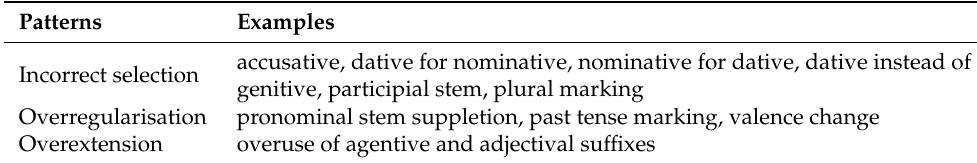
Table 3. Grammatical patterns in child commission errors in